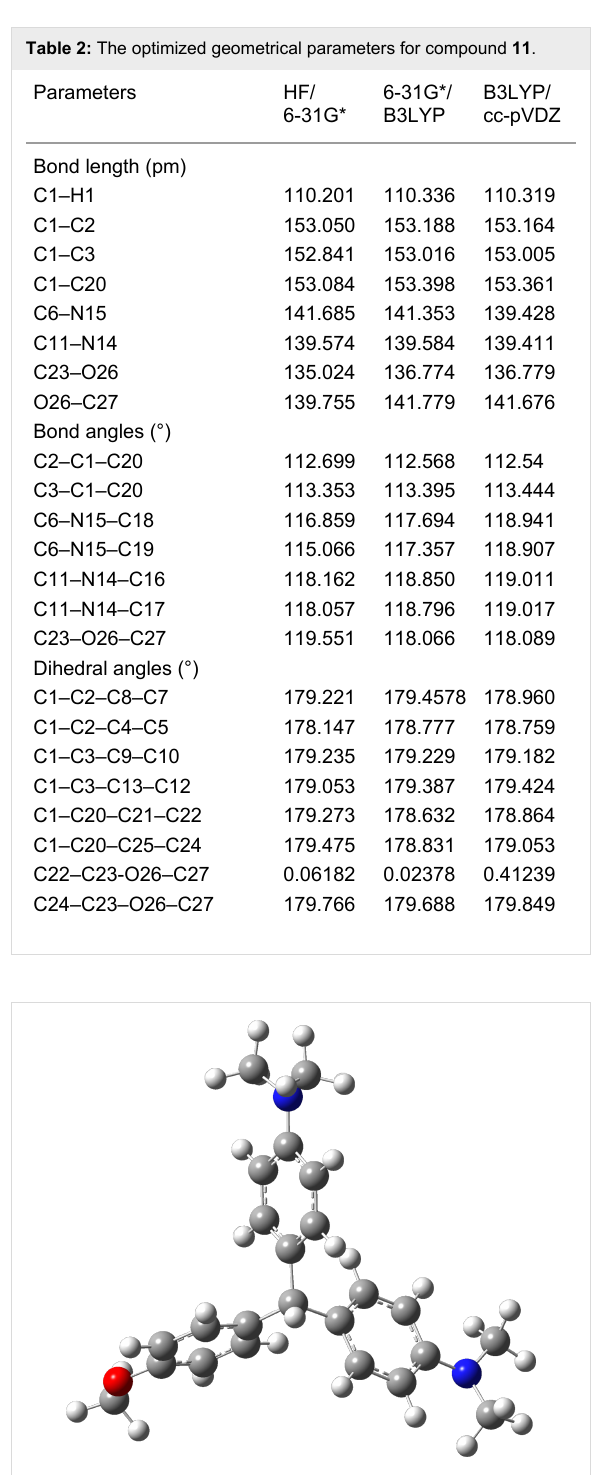
Figure 2: The molecular structure of compound 11 optimized by the B3LYP/cc-pVDZ method